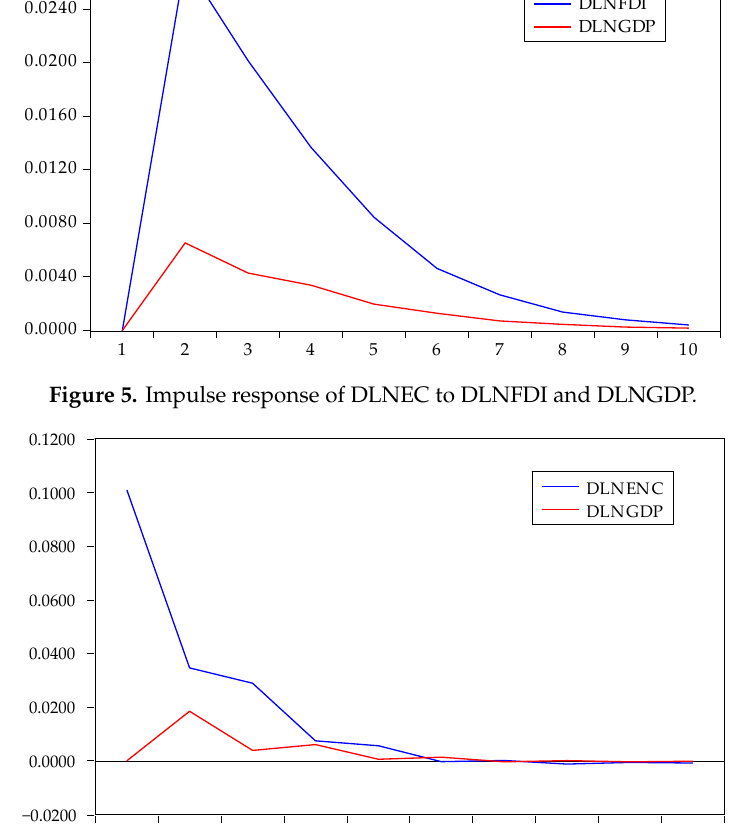
Figure 5. Impulse response of DLNEC to DLNFDI and DLNGDP.